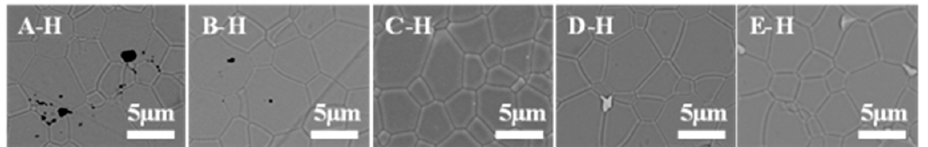
Figure 5. SEM images of different (Tb+Y)/Al ratio samples ( A – E represent 0.5964, 0.6000, 0.6036, 0.6073 and 0.6110) pre-sintered at 1450 °C and with 1600 °C HIP treatment.